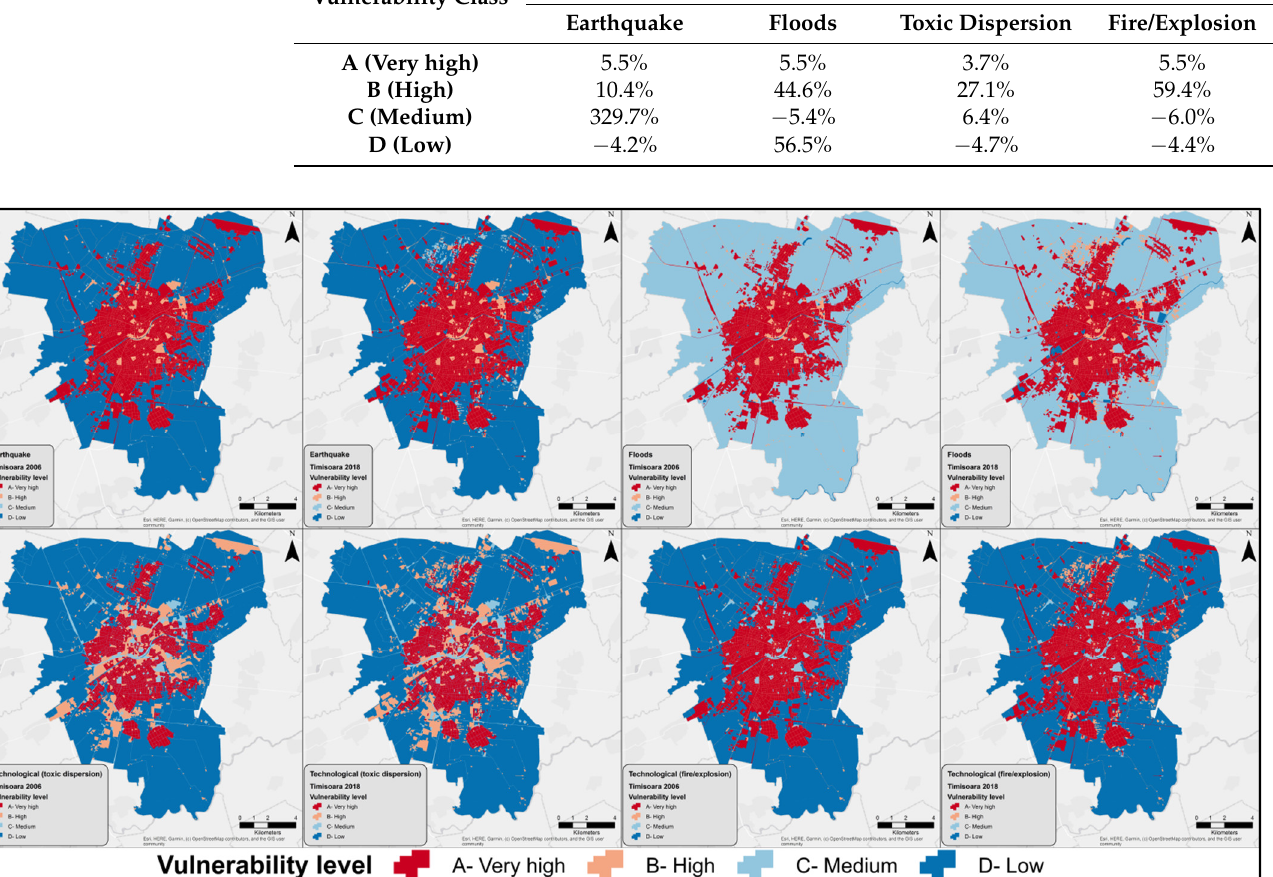
Table 3. Summary of vulnerability level variation between 2006 and 2018 in Timis